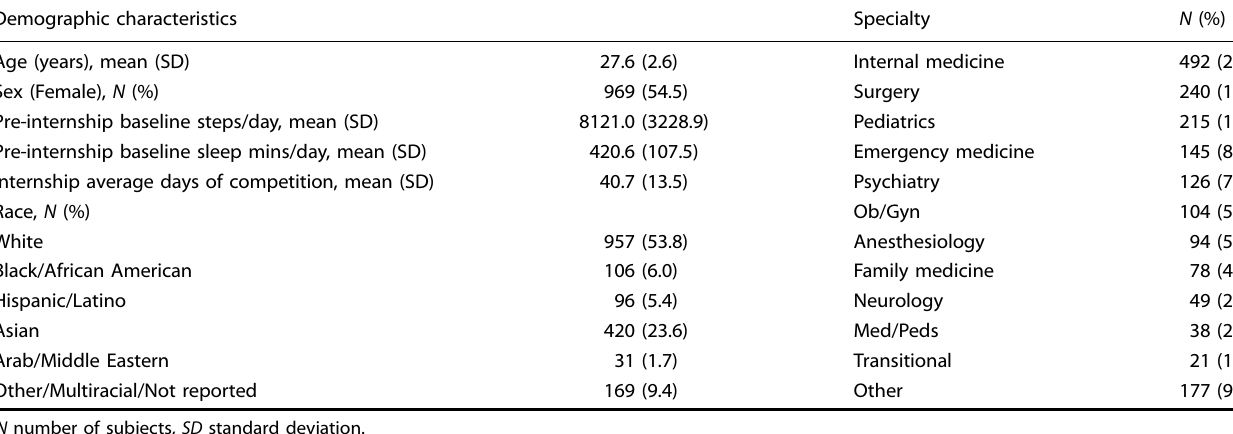
Table 1. Demographics characteristics and specialty for study participants ( N = 1779).